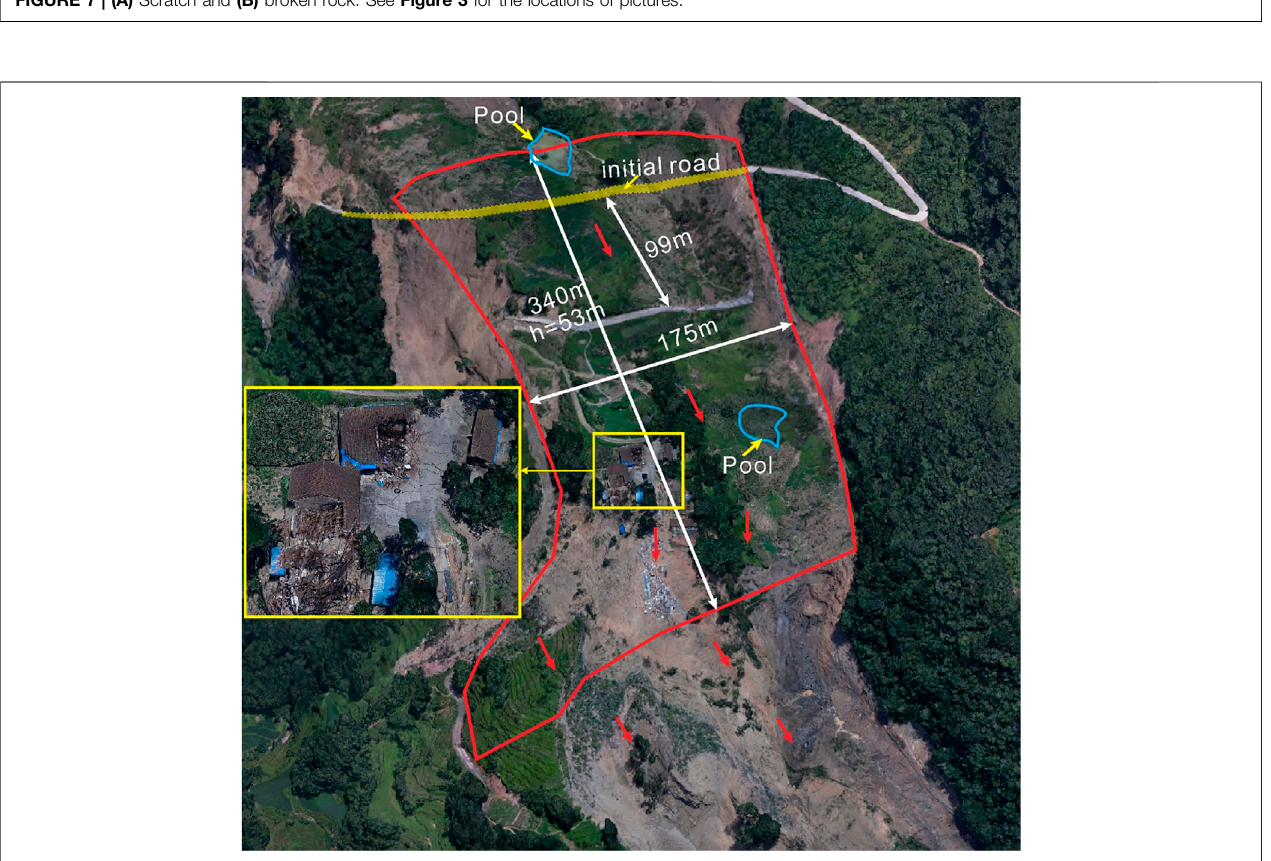
FIGURE8| Pictureoftransportationarea.Thesub-picture isthevillagewhichshowsthatmostofthosebuildings maintaingoodintegrity.Theroadalso keptgood continuity across two sides, even though it slid over 90 m. The blues line are pools.